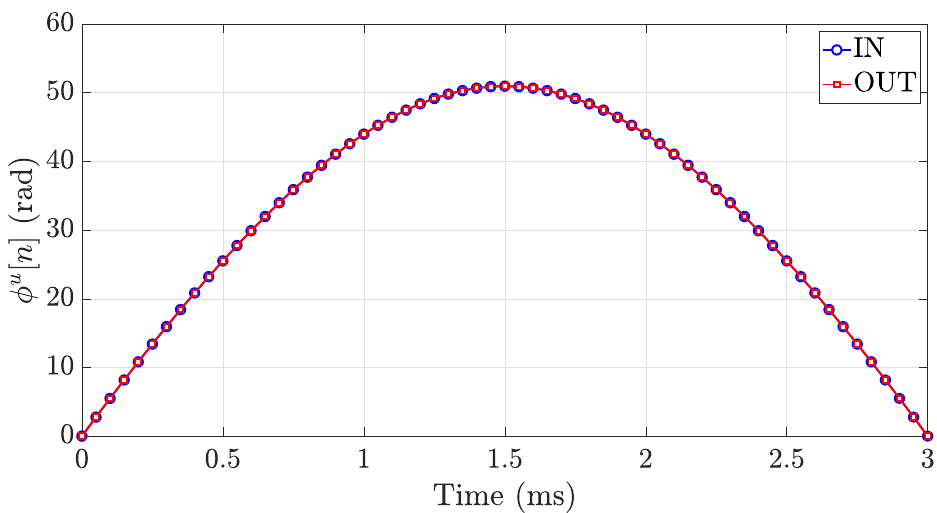
Figure 9. Time behavior of the unwrapped normalized phase in the symmetrical configuration of the RFID Smart Gate for the following system parameters: f = 865.7 MHz, l = 3 m, v = 2 m/s, ∆ h = 2.5 m, and T = 50 ms.